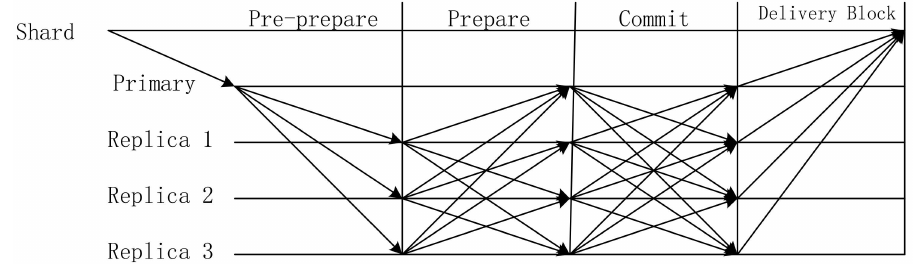
Figure 6. Consensus process of transaction fragmentation consensus